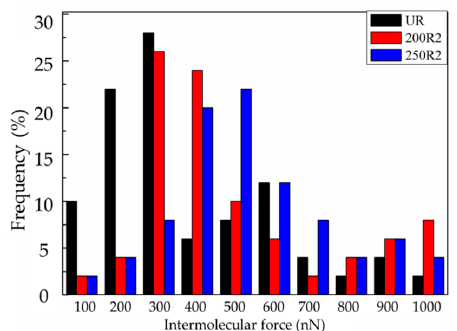
Figure 9. A typical intermolecular interaction force between the C–S–H probe and the rubber, measured with AFM. ( a ) As-received rubber; ( b ) rubber treated at 200 °C with air/nitrogen = 1/4; and ( c ) rubber treated at 250 °C with air/nitrogen = 1/4.